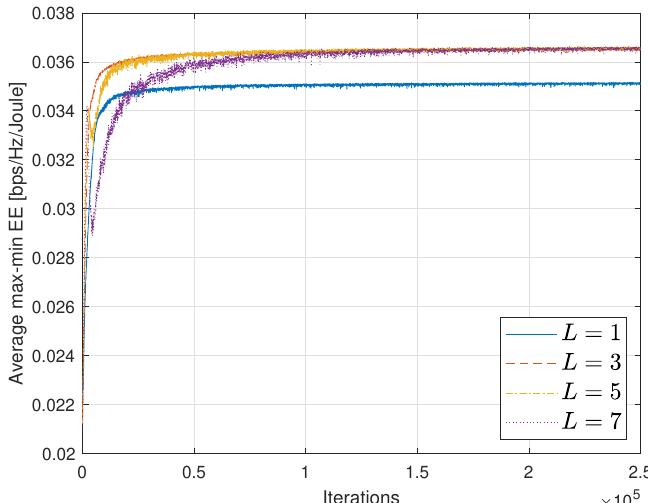
Figure 5. Convergence of validation performance with K = 4, P C = 33 dBm, and P = 30 dBm for different L .